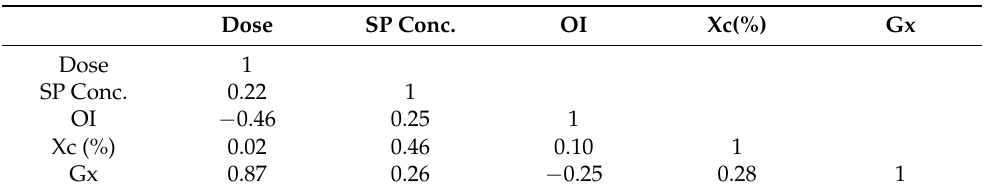
Table 6. Correlation matrix for in-depth investigation of dose and SP concentration on the OI, Xc (%), and